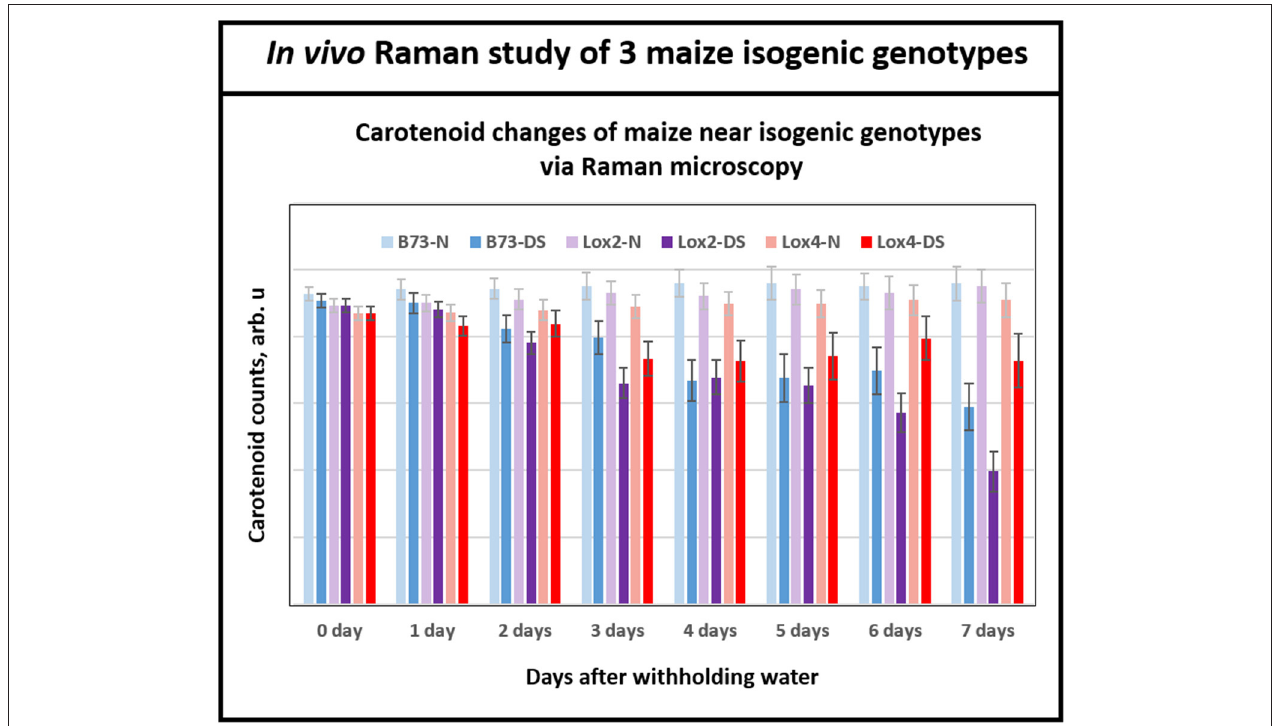
FIGURE 5 | Histogram of a change in the carotenoid content of plants in B73 and near-isogenic lox 2 and lox 4 mutants. While at the beginning of withholding water, all three genotypes showed similar levels of carotenoids, by day 6 and 7 all three genotypes displayed clear separations of carotenoid level between control and drought stressed plants. Each bar represents the mean + SE ( n = 3 × 5).